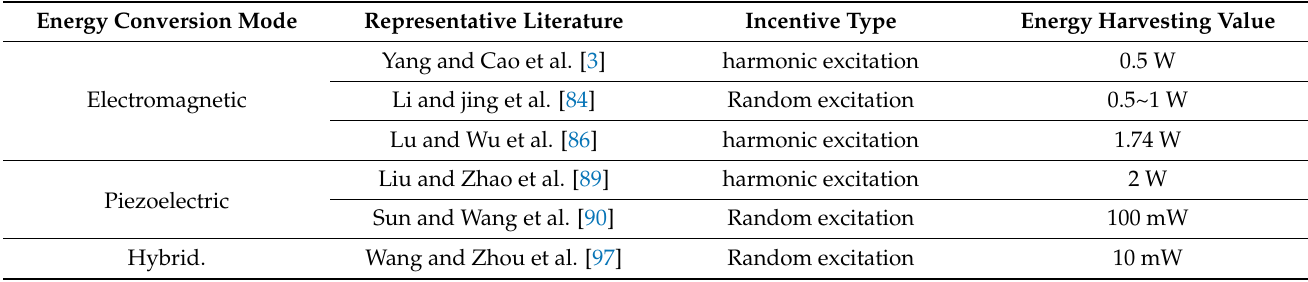
Table 3. Comparisons of four QZS implementation